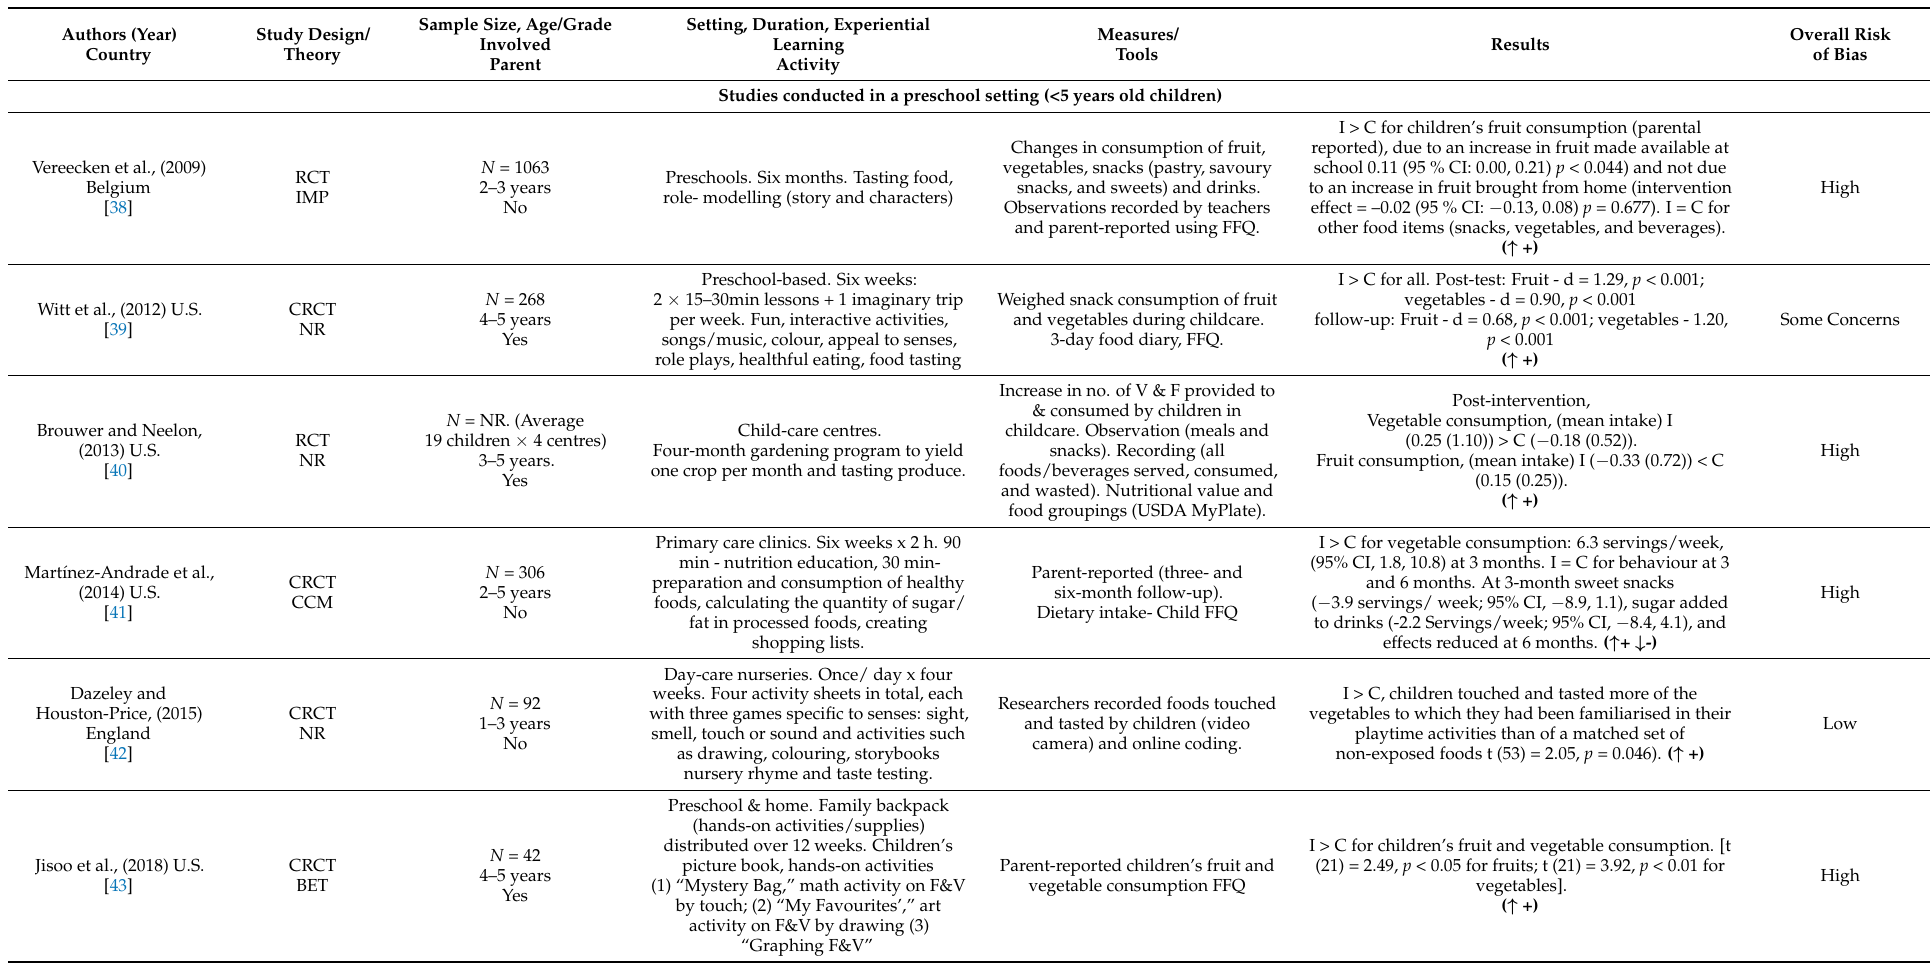
Table 2. Experiential learning interventions and healthy eating outcomes in